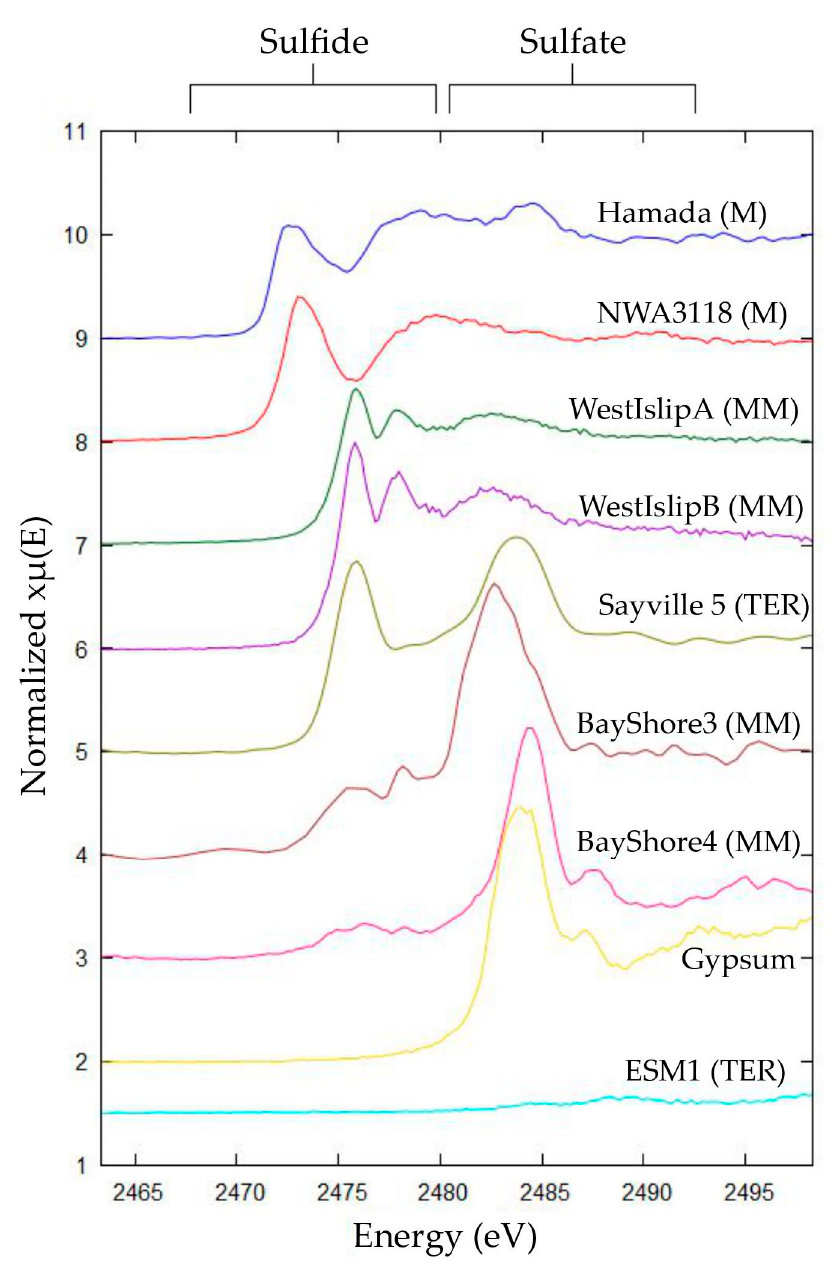
Figure 9. Sulfur X-ray absorption near-edge structure (XANES) spectra using tender energy X-ray absorption spectroscopy (TES) indicating sulfur speciation in meteorites (Ms), micrometeorites (MMs), and terrestrial particles (TERs). Gypsum was used as a standard for sulfate. The left-shifted peaks are representative of possibly extraterrestrial sulfide species of sulfur.